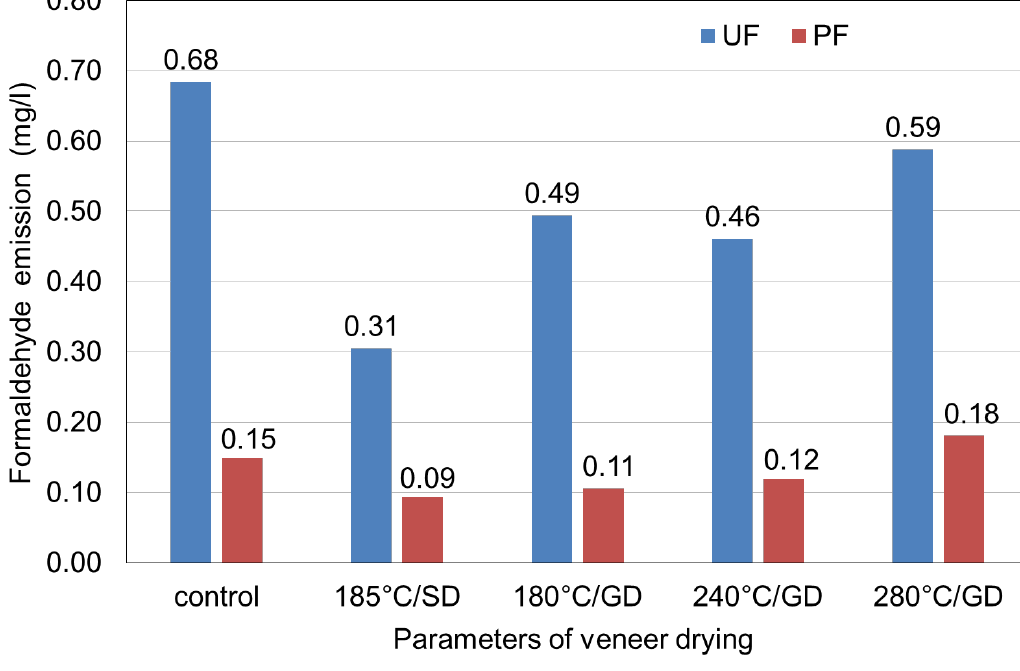
Figure 2. Formaldehyde emission of plywood panels.